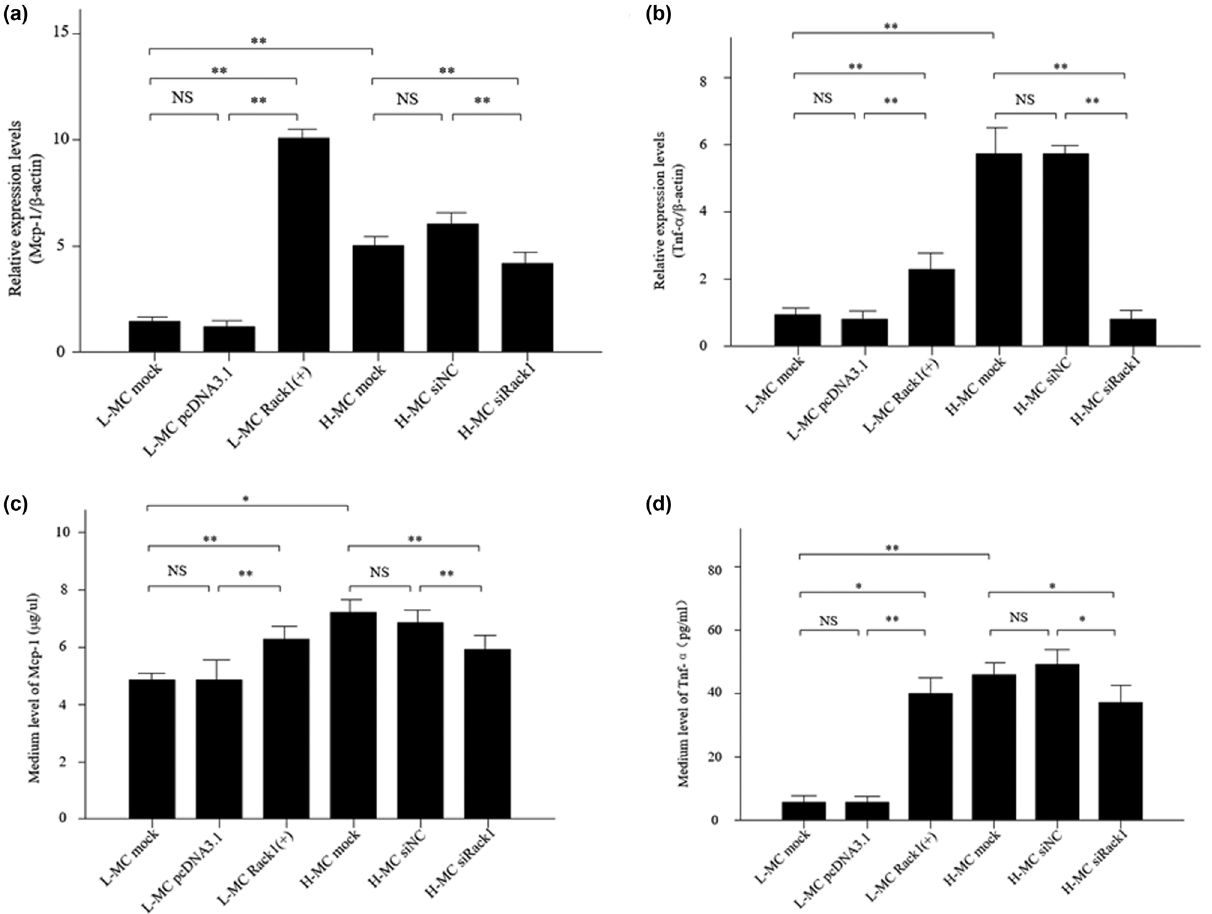
Figure 4: Rack1 promotes the expression of in fl ammatory factors in mesangial cells under high glucose conditions. ( a ) The expression of Mcp - 1 was regulated by Rack1 by qRT - PCR. The result showed that the expression of Mcp - 1 was signi fi cantly increased in mesangial cells transfected with Rack1 overexpression plasmid Rack1 (+) in the L - MC group compared with that in cells transfected with empty plasmid pcDNA3.1 and untreated cells, while the expression of Mcp - 1 was decreased in mesangial cells transfected with siRack1 in the H - MC group compared with that in cells transfected with the siRNA control and untreated cells. The data are representative of three independent experiments. Data are presented as mean ± SD. ** p < 0.01; NS, not signi fi cant. ( b ) The expression of Tnf - α was regulated by Rack1 by qRT - PCR. The result showed that the expression of Tnf - α was signi fi cantly increased in mesangial cells transfected with Rack1 overexpression plasmid Rack1 (+) in the L - MC group compared with that in cells transfected with empty plasmid pcDNA3.1 and untreated cells, while the expression of Tnf - α was decreased in mesangial cells transfected with siRack1 in the H - MC group compared with that in cells transfected with the siRNA control and untreated cells. The data are representative of three independent experiments. Data are presented as mean ± SD. ** p < 0.01;, NS, not signi fi cant. ( c ) The expression of Mcp - 1 was regulated by Rack1 by ELISA. The result showed that the expression of Mcp - 1 was signi fi cantly increased in mesangial cells transfected with Rack1 overexpression plasmid Rack1 (+) in the L - MC group compared with that in cells transfected with empty plasmid pcDNA3.1 and untreated cells, while the expression of Mcp - 1 was decreased in mesangial cells transfected with siRack1 in the H - MC group compared with that in cells transfected with the siRNA control and untreated cells. The data are representative of three independent experiments. Data are presented as mean ± SD. * p < 0.05, ** p < 0.01; NS, not signi fi cant. ( d ) The expression of Tnf - α was regulated by Rack1 by ELISA. The result showed that the expression of Tnf - α was signi fi cantly increased in mesangial cells transfected with Rack1 overexpression plasmid Rack1 (+) in the L - MC group compared with that in cells transfected with empty plasmid pcDNA3.1 and untreated cells, while the expression of Tnf - α was decreased in mesangial cells transfected with siRack1 in the H - MC group compared with that in cells transfected with the siRNA control and untreated cells. The data are representative of three independent experiments. Data are presented as mean ± SD. * p < 0.05, ** p < 0.01; NS, not signi fi